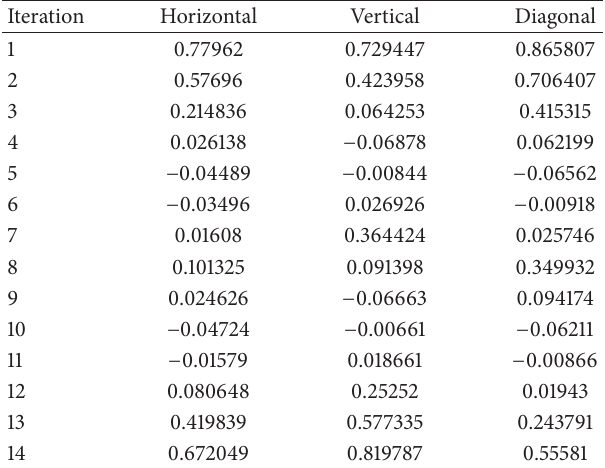
Table 6: The evaluation results of Figure 3 by gap test with different upper bound value.